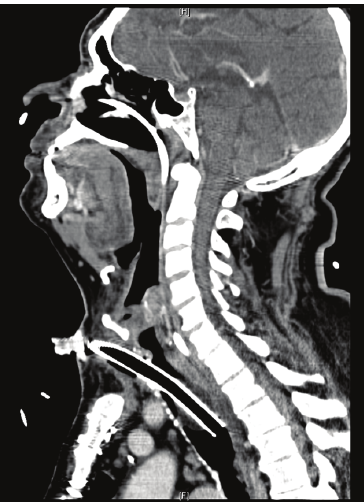
Figure 2: Postoperative Neck Soft Tissue CT revealing diffuse tracheal